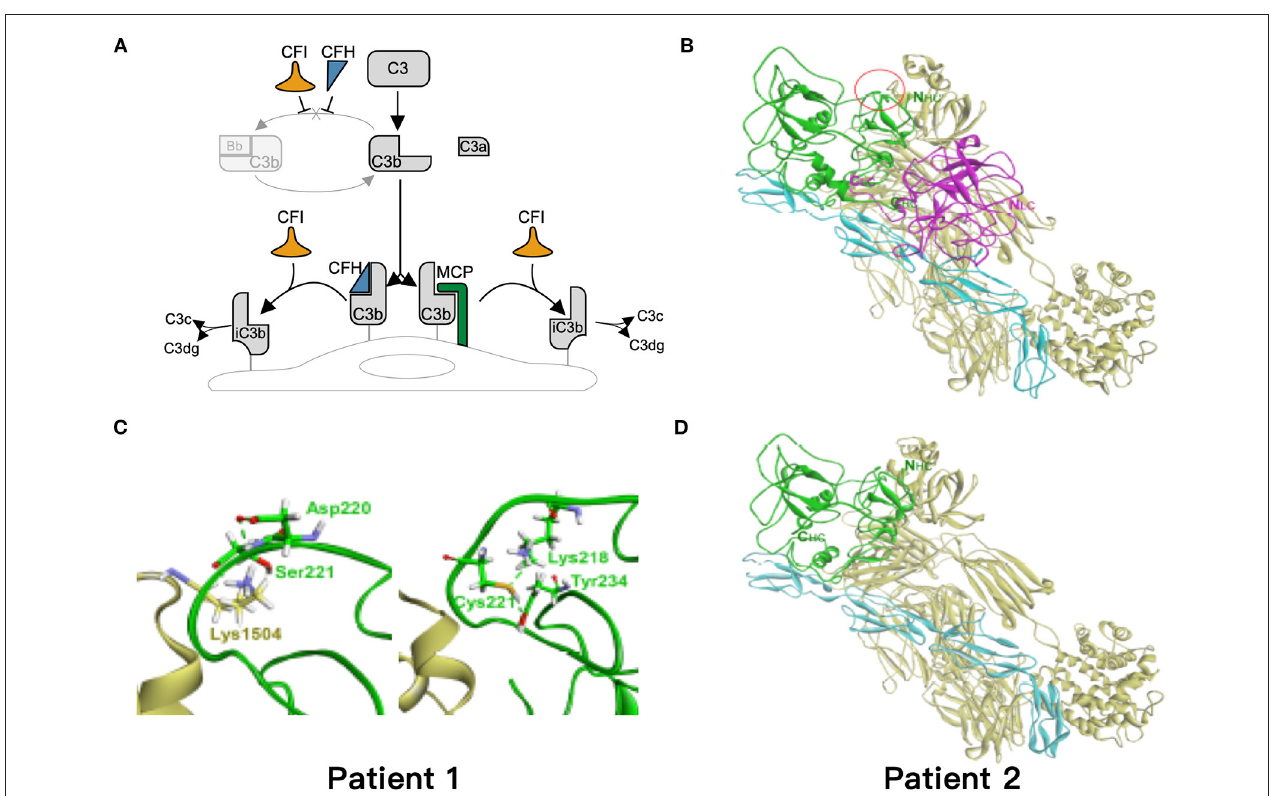
FIGURE 4 | Simulation of the mutant models. (A) Regulation of the alternative complement pathway. CFI is responsible for the proteolytic inactivation of C3b to inactive C3b (iC3b) and irreversibly preventing reassembly of the C3 convertase. CFH and MCP acts as cofactors for CFI in the cleavage of C3b to iC3b. (B) The models of ternary complex of factor I (FI), factor H, and C3b. The proteins are presented as ribbon model and colored green and magenta for the heavy and light chain of FI, respectively, and cyan and yellow for factor H and C3b, respectively. (C) The red cycle represents the site for Ser221 in wild type and Cys221 in mutant FI, respectively. (D) The E302X mutant FI in complex with factor H and C3b. The hydrogen bond is shown as dashed green